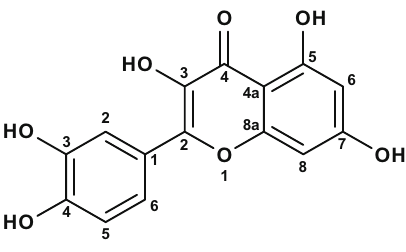
Figure 5: The numbering system in quercetin molecule, 2 -( 3,4 - dihydroxyphenyl )- 3,5,7 - trihydroxy - 4 H - chromen - 4 - one showing carbon 1 – 8.